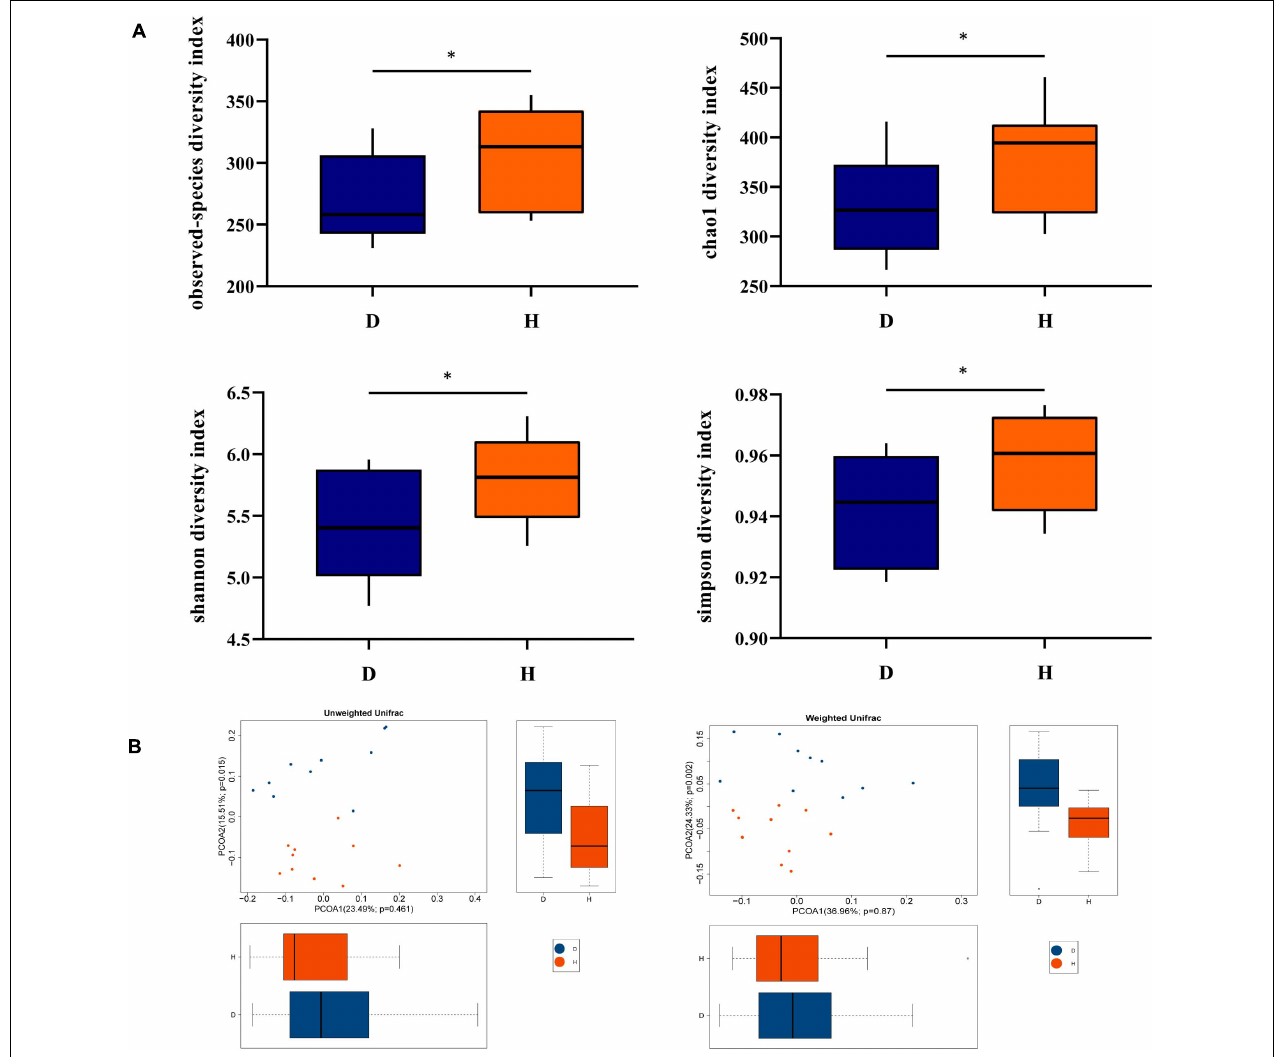
FIGURE 1 | Diversity analysis of fecal microbiota between groups D and H. (A) Alpha diversity is the index of species variety in a single sample, including the observed species, chao1, shannon, and simpson. (B) Principal Coordinates Analysis (PCoA) was used to further demonstrate the differences in species diversity between samples, it can reveal the magnitude of the differences between samples. PCoA analysis results of species diversity between samples, if two samples are close to each other, it means that the species composition of these two samples is similar (D, Diarrhea; H, Health). *difference between the two groups is significant( p <